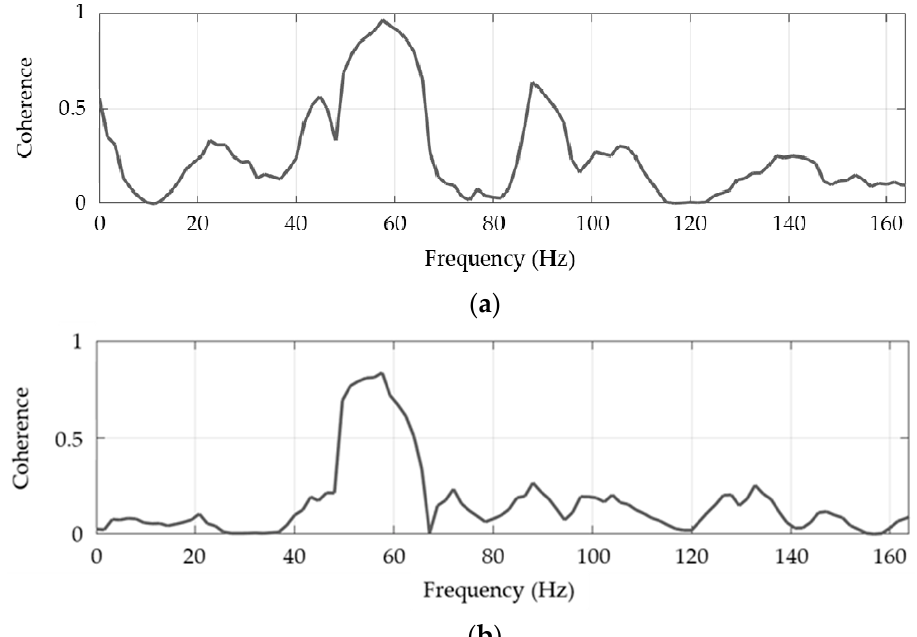
Figure 15. ICA-based ordinary coherence: ( a ) γ (cid:2869)(cid:3052)(cid:2870) , ( b ) γ (cid:2870)(cid:3052)(cid:2870) .